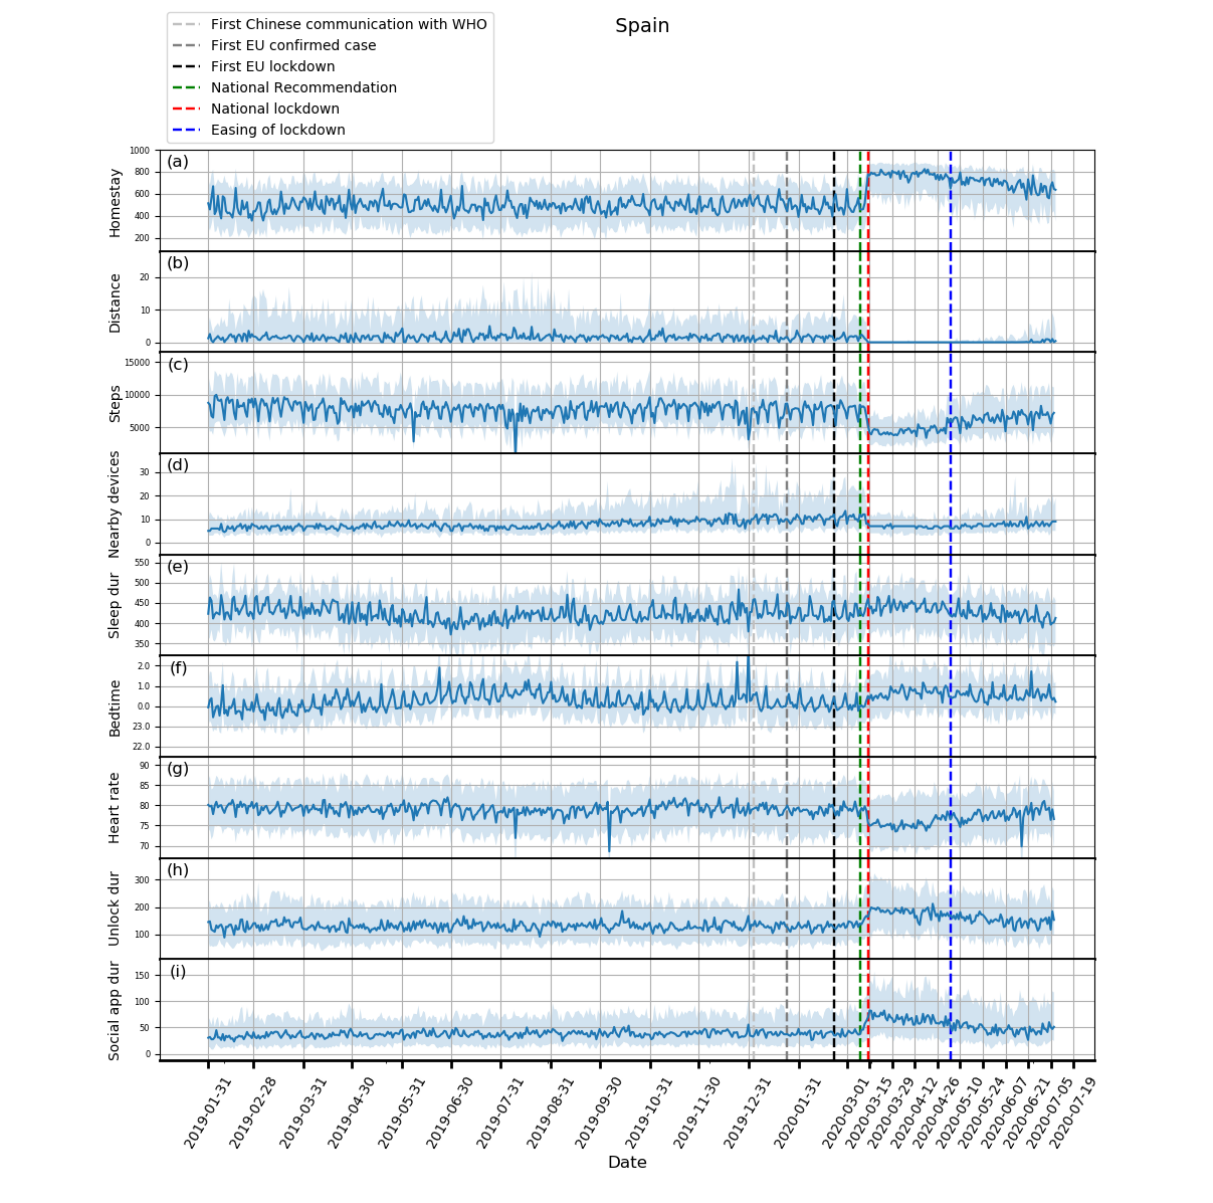
Figure 2. Behavioral changes for Spain (329 participants). (a) homestay duration, (b) maximum distance from home, (c) Fitbit step count, (d) maximum number of nearby devices, (e) total sleep duration, (f) bedtime, (g) heart rate, (h) unlock duration, (i) social app duration. Solid line: median; shade: 25th percentile to 75th percentile. dur: duration; WHO: World Health